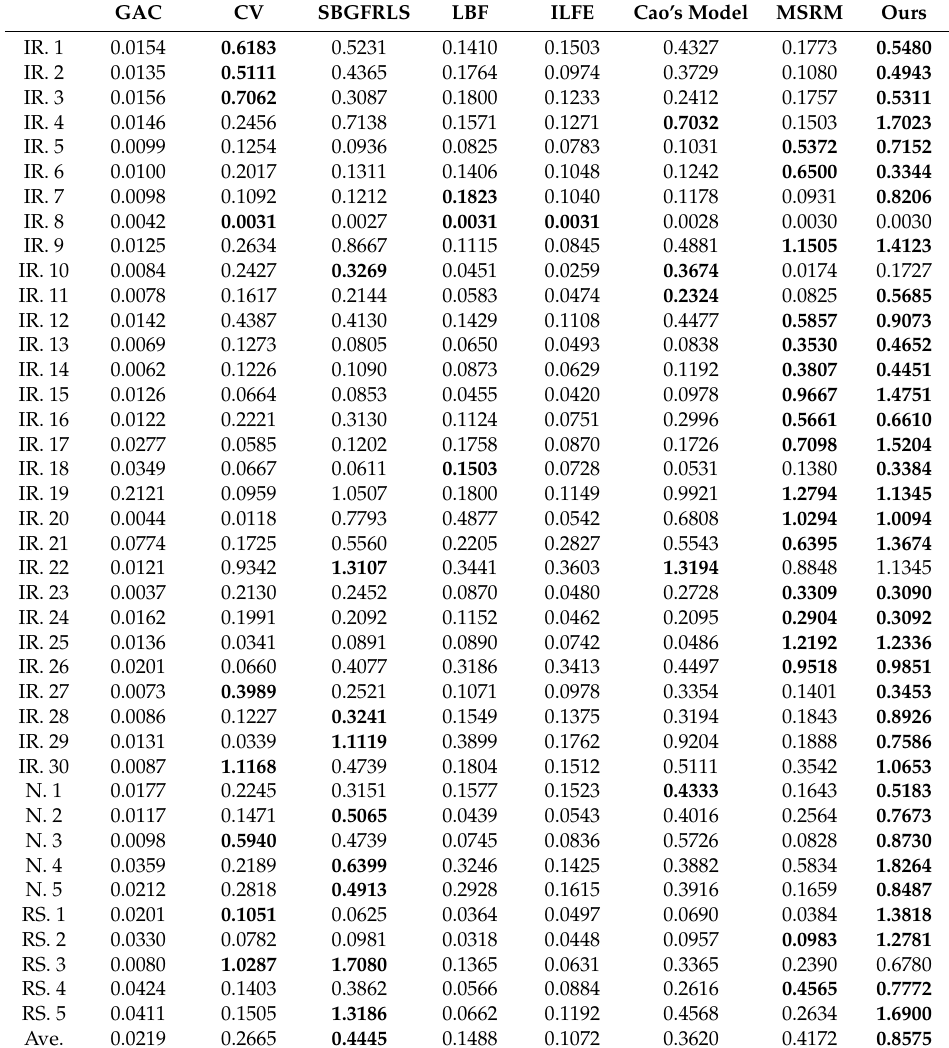
Table 3. Statistic for BP values, and bold values indicate the top two